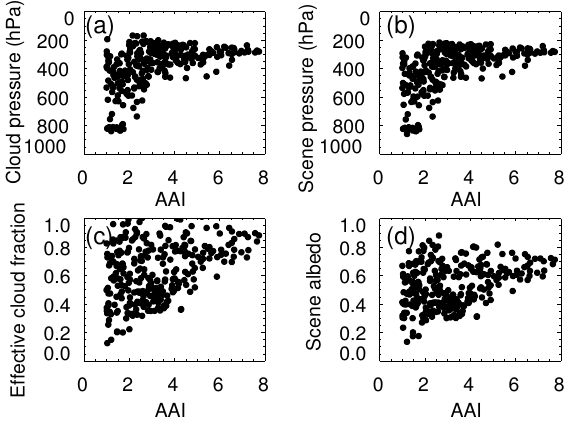
Fig. 10. Scatter plots of FRESCO (a) cloud pressure, (b) scene pres- sure, (c) effective cloud fraction, and (d) scene albedo versus ab- sorbing aerosol index (AAI) from GOME-2 measurements of the Puyehue volcanic ash plume on 5 June 2011 around 12:50UTC. The pixels used in the scatter plots are marked with a box in Fig. 9 in the region of [35, 47] ◦ S and [50, 70] ◦